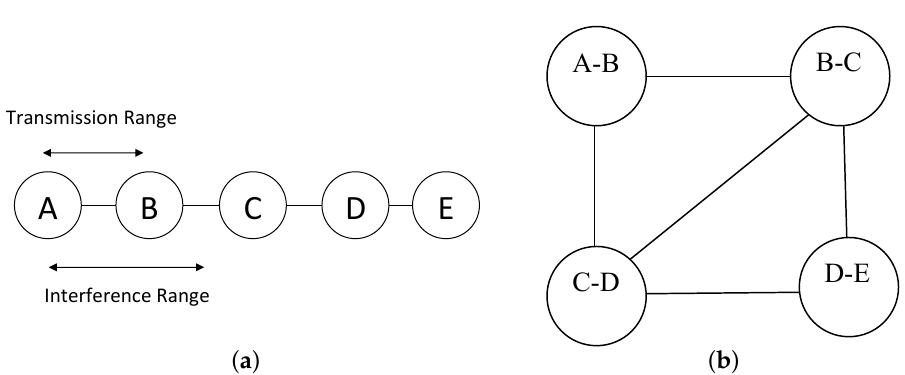
Figure 4. Illustration of ( a ) a five node connectivity graph and ( b ) its corresponding conflict